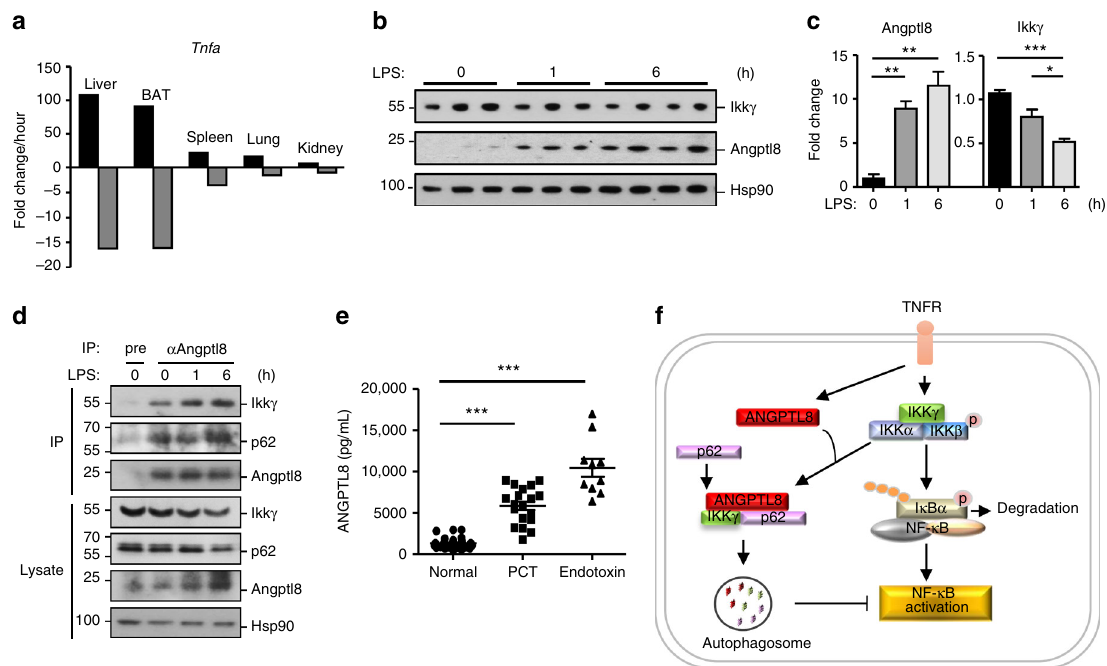
Fig. 10 Potential involvement of ANGPTL8 in the acute in fl ammation caused by infection. a The upregulation and downregulation rate of Tnfa transcription during the acute phase (0 – 1 h) and the resolution phase (1 – 6 h) upon LPS infection. The upregulation rate was determined by the fold change between 0 – 1 h, while the downregulation rate was determined by the fold change per hour between 1 – 6 h after the injection. ( n = 3 for 0 and 1 h, n = 4 for 6 h). b , c The immunoblots ( b ) and quantitation results ( c ) of the expression of Ikk γ and Angptl8 in the liver upon LPS infection. Each lane stands for one mouse. d Angptl8 forms a complex with Ikk γ and p62 upon LPS infection. Equal amount of lysate obtained from each animal at the same time point were mixed, and subjected to Co-IP experiment ( n = 3 for 0 and 1 h, n = 4 for 6 h). e The circulating ANGPTL8 was elevated in patients with positive detection of PCT or endotoxin (healthy control, n = 30; PCT, n = 18; endotoxin, n = 10). f A working model of ANGTPL8 mediated regulation of TNF α -induced signaling. TNF α upregulates the expression of ANGPTL8, and then aggregated ANGPTL8 facilitates the ANGPTL8-p62-IKK γ complex formation, which promotes the autophagic IKK γ degradation and inhibits TNF α -induced NF- κ B activation. Data are shown as the mean ± SEM in c , e , unpaired two-tailed Student ’ s test was used for statistics. *** p < 0.0001, ** p < 0.01, * p < primers for CXCL2 , IL8 , NFKBIA , TNFA , and GAPDH were as we previously described 58,59 . CRISPR-Cas9-mediated knockout of ANGPTL8 . The CRISPR-Cas9 based pro- tocols for genome engineering were used as described 60 . PGL-U6-GRNA and PST1374-Cas9 plasmids were gifts of Dr. X. Zhang (Wuhan University). The ANGPTL8 gRNA target sequence and the identi fi cation primers for ANGPTL8 knockout are listed in Supplementary Table 3.